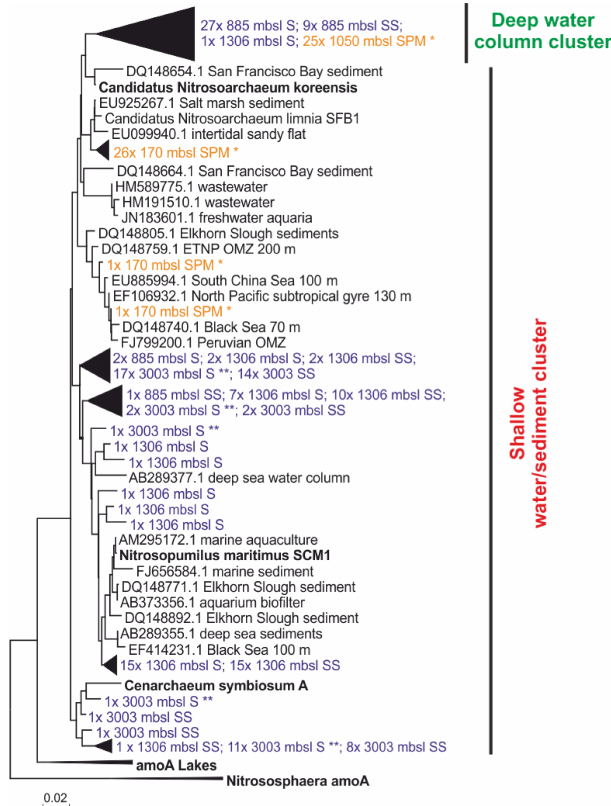
Figure 4. Maximum likelihood phylogenetic tree of amo A gene coding sequences recovered from surface (S; 0–0.5cm) and subsur- face (SS; 10–12cm) sediments (colored in blue) at 885, 1306 and 3003mb.s.l. (155 clones). Amo A gene coding sequences recovered from SPM (colored in orange) at 170mb.s.l. (28 clones); SPM at 1050mb.s.l. (25 clones) reported by Villanueva et al. (2014). ∗∗ in- dicates amo A gene sequences recovered from surface sediments at 3003mb.s.l. previously reported in Villanueva et al. (2014). The scale bar represents a 2% sequence